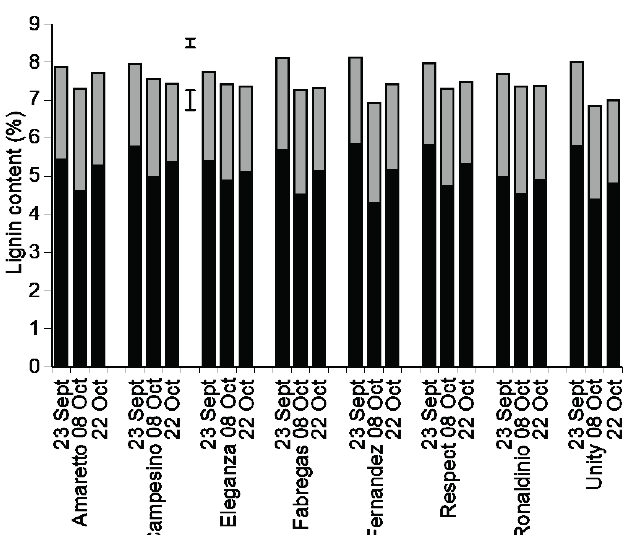
Fig. 1. Acid-insoluble (black bars) and acid-soluble (grey bars) lignin content of 8 cultivars of maize harvested on 3 dates in 2010. Error bars show LSD of (upper bar) acid-soluble and (lower bar) –insoluble lignin.